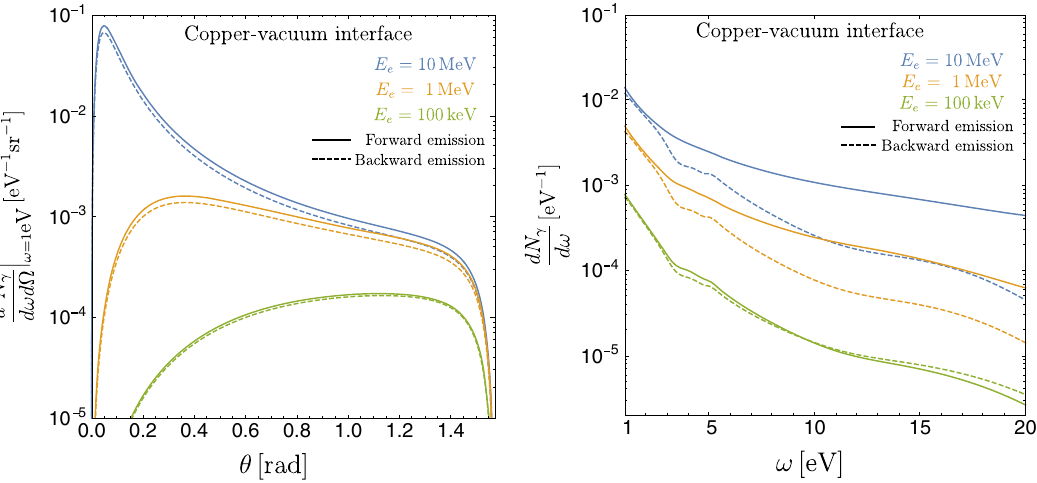
¼ 10 MeV (blue lines), e